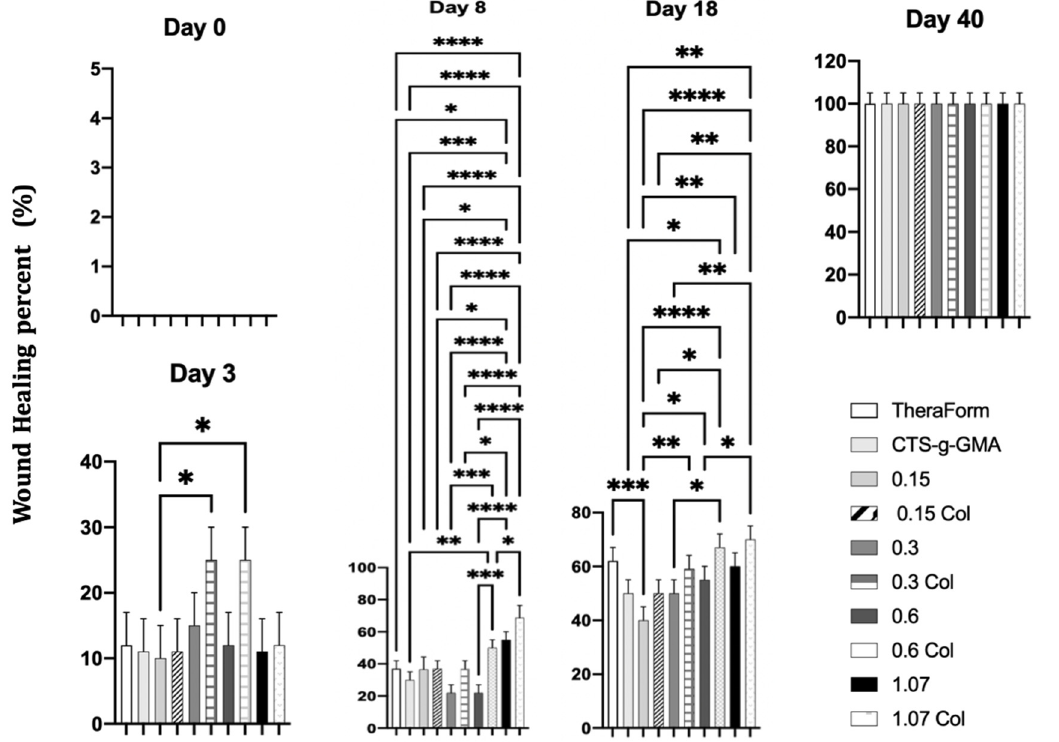
Figure 10. Wound healing percentage after 40 days, with TheraForm ® ; CTS-g-GMA; (CTS-g-GMA)- AuNPs at different concentrations—0.15, 0.3, 0.6, 1.07 mM; and ((CTS-g-GMA)-AuNPs)-Col at different concentrations—0.15, 0.3, 0.6, 1.07 mM. ( p < 0.05), n = 3, SD ± 0.5. The asterisk means that there are note significant differences between that samples.